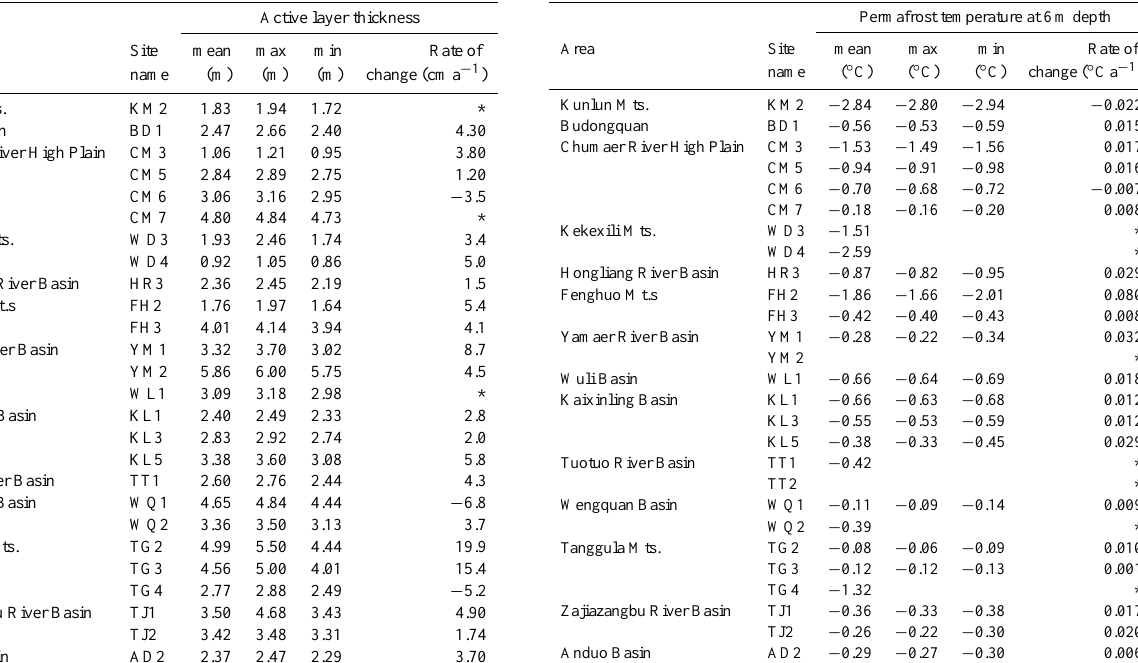
Table 2. Multi-year mean, maximum, minimum, and changing rate of active layer thickness along the QXR from 2006–2010.